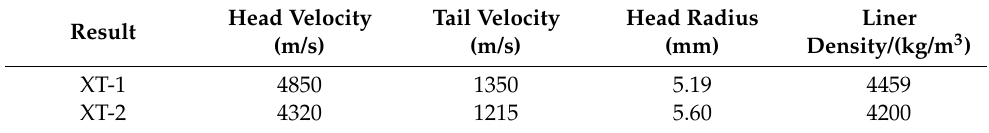
Table 2. The main data of the measured jet.